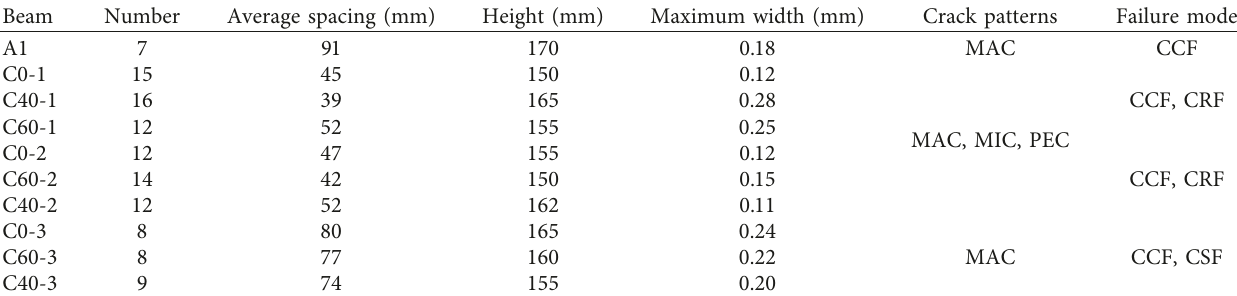
Table 6: Parameters of cracks in the pure bending span.